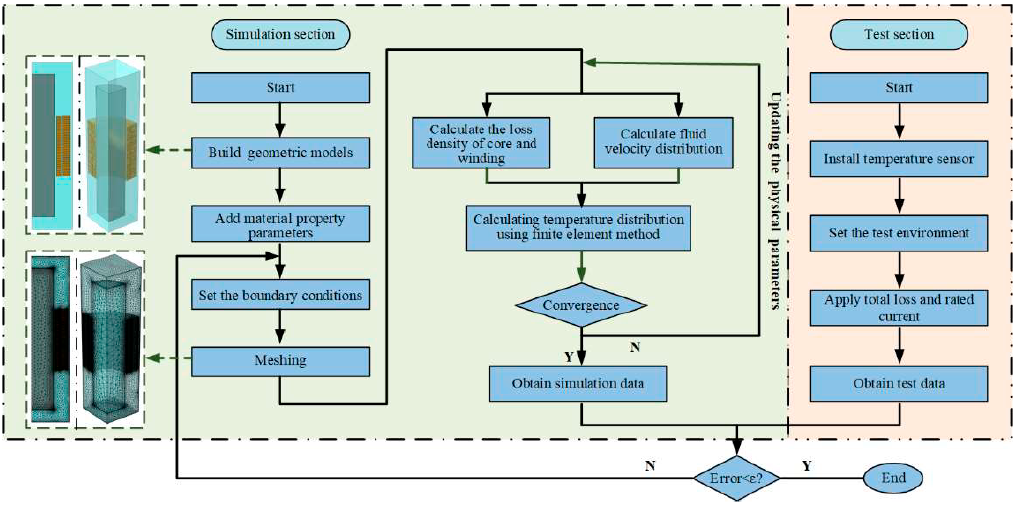
Figure 2. Flowchart for temperature computation.